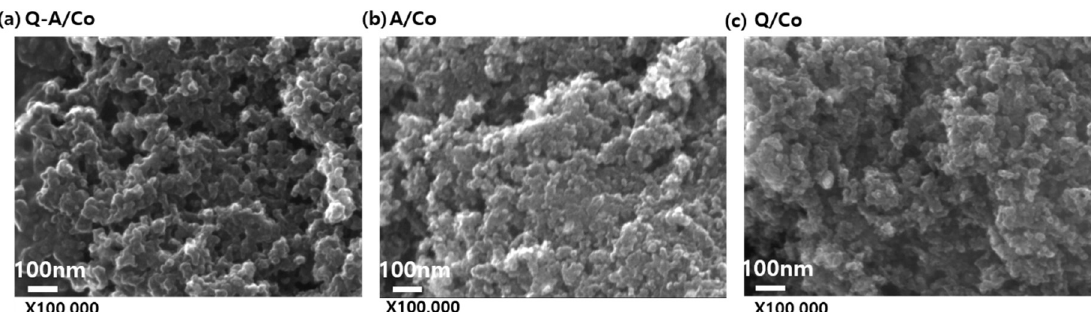
Figure2. SEMimagesofthe( a )quaternary-Nandamino-N-dopedcarbon(Q-A / Co), ( b )amino-N-doped Figure 2. SEM images of the ( a ) quaternary-N and amino-N-doped carbon (Q-A/Co), ( b ) amino-N- carbon (A / Co), and ( c ) quaternary-N-doped carbon (Q / Co) doped carbon (A/Co), and ( c ) quaternary-N-doped carbon (Q/Co) catalysts.